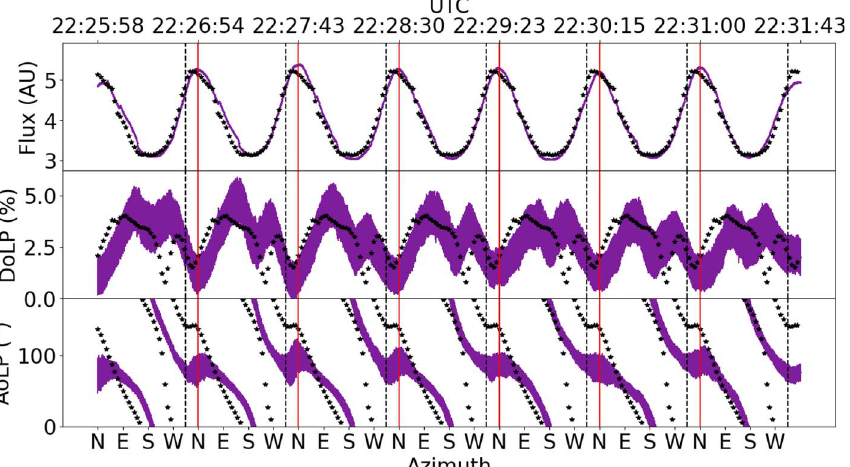
Fig. 9. 7 almucantar observations at 391.4 ± 5 nm (February 27, 2020): observations (in purple) and predictions for the model that best fi ts the data (Black stars H ). The model is a linear combination of ground and sky (including albedo) for a 11% polarised sky emission in a direction de fi ned by an azimuth of 50 (cid:3) and (cid:3) 20 (cid:3) elevation (see text for details). The dashed vertical black line indicates the direction of Skibotn. The picture of the sky at 557.7 nm is shown in Appendix A. The emissions at 391.4 nm (purple) are considered to be